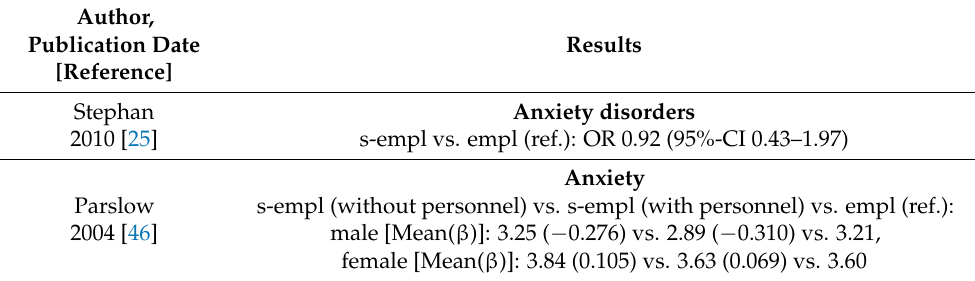
Table 8. Anxiety —results of cross-sectional studies of good quality on mental disorders comparing self-employed (s-empl) vs. employees